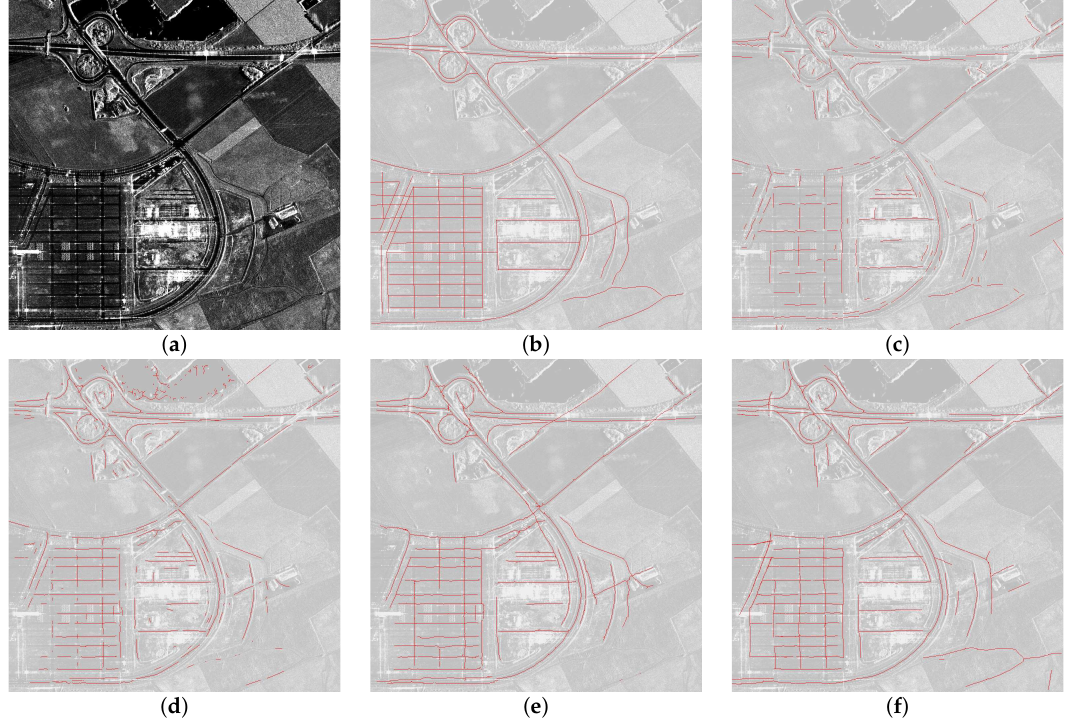
Figure 5. The experimental results on the TerraSAR image from Trudering, Germany. ( a ) The original image; ( b ) ground truth; ( c ) results of MLFD; ( d ) results of beamlet; ( e ) results of Markov random field (MRF) [8]; ( f ) fusion results of